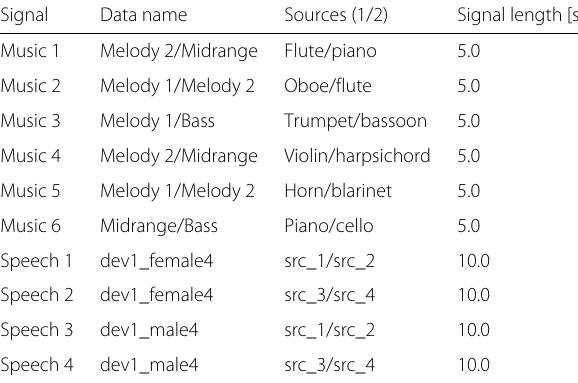
Table 3 Dry sources used in two-source